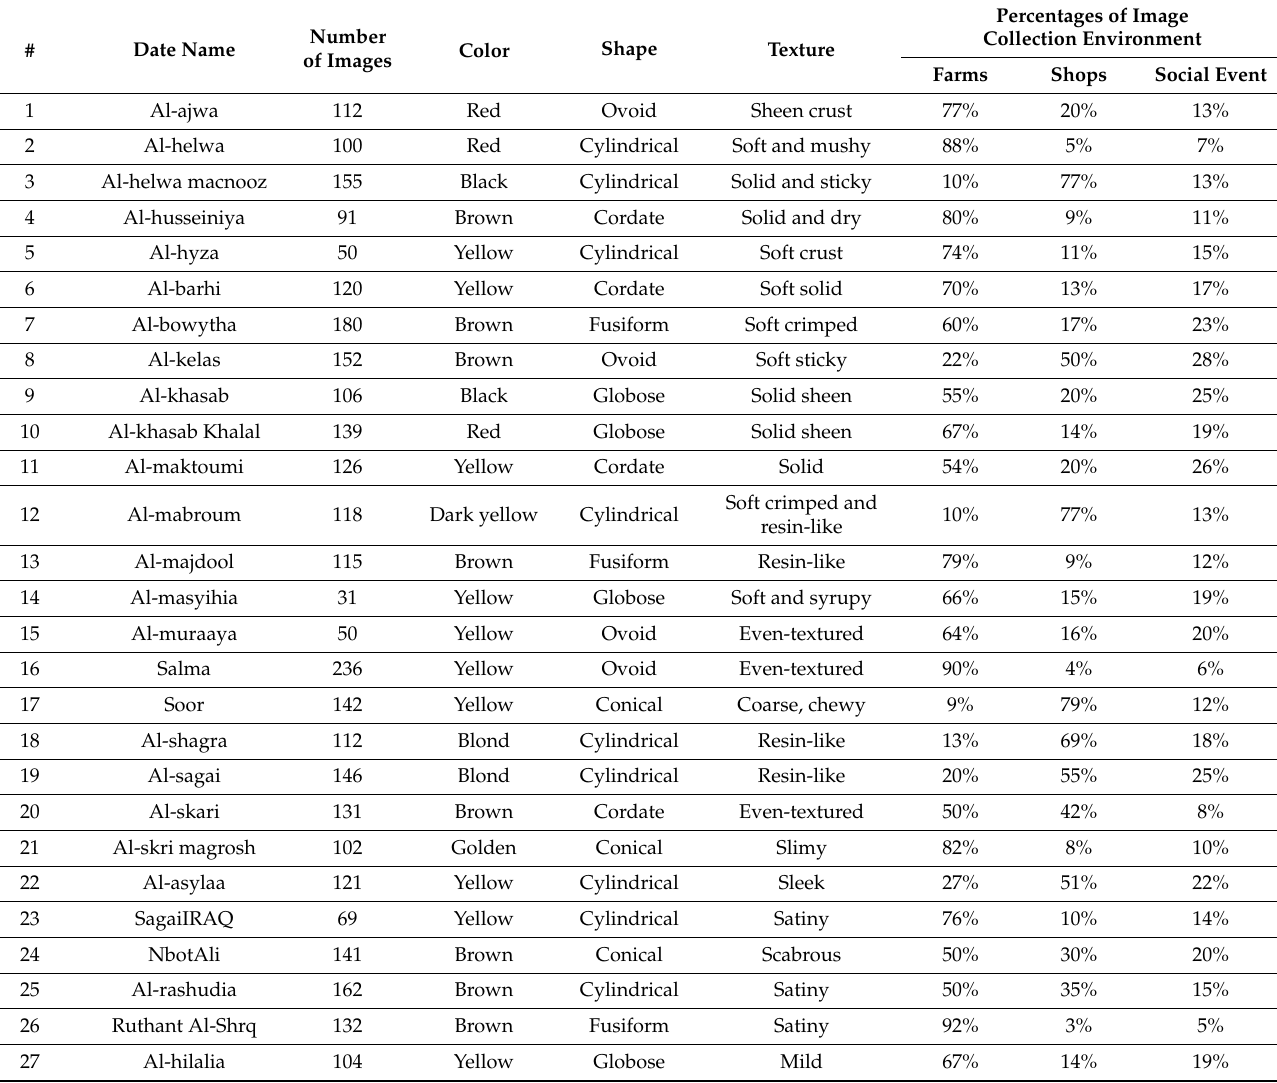
Table 4. The dataset classes’ details including the date’s name, number of images, color, shape, texture, and the percentages of the image collection